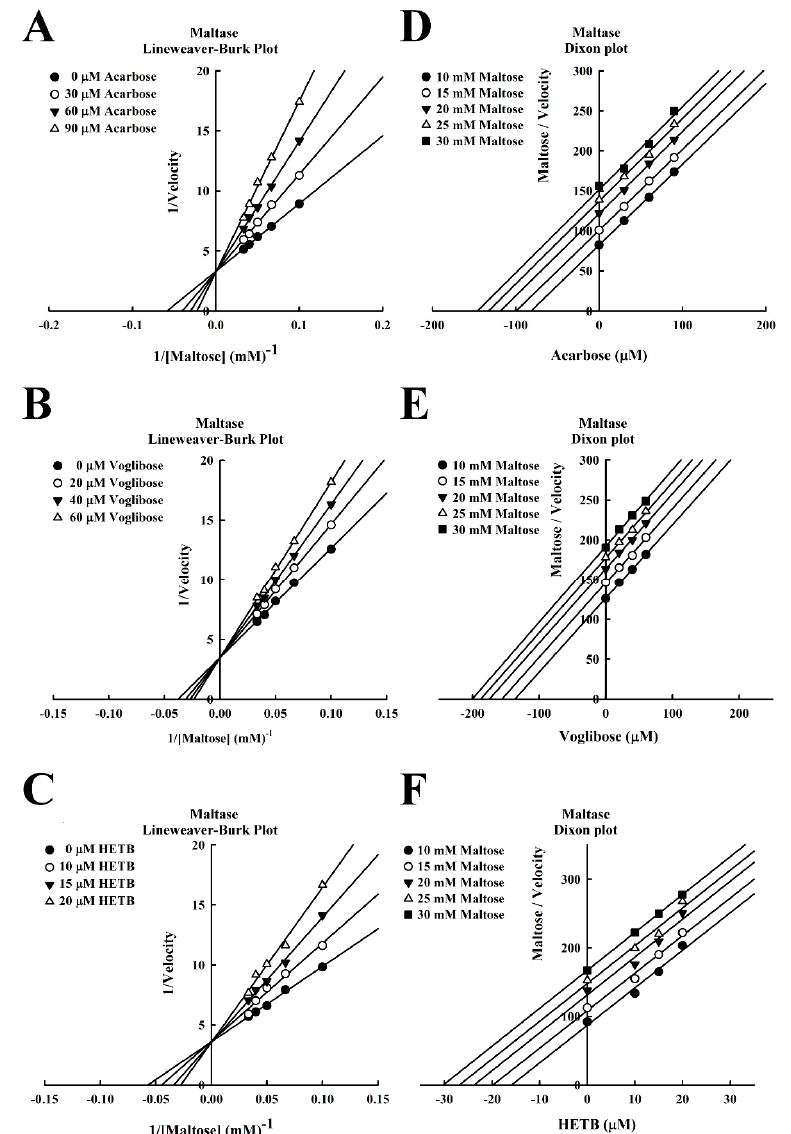
Figure 4. Lineweaver-Burk ( A – C ) and Dixon plots ( D – F ) of inhibitory effect of maltase inhibitors on maltase. ( A ) Acarbose, ( B ) Voglibose, ( C ) HETB, and ( D ) Acarbose, ( E ) Voglibose, ( F ) HETB. Each sample was analyzed in triplicate.